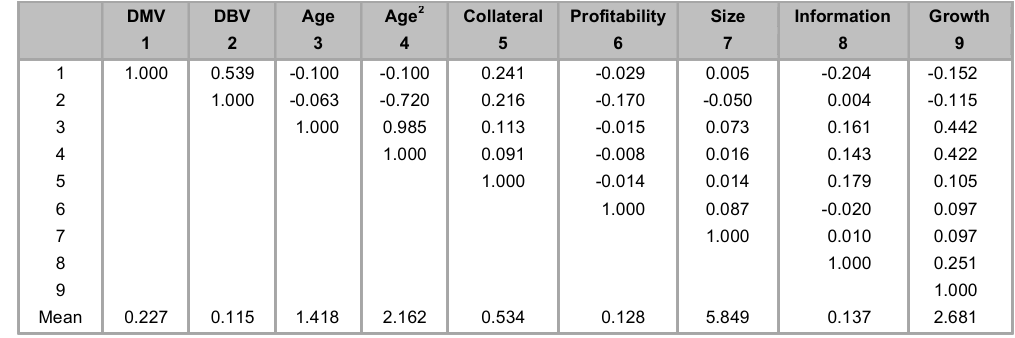
statistics and correlation analysis for all the variables. For the whole sample, DMV and respectively. Collateral value averages